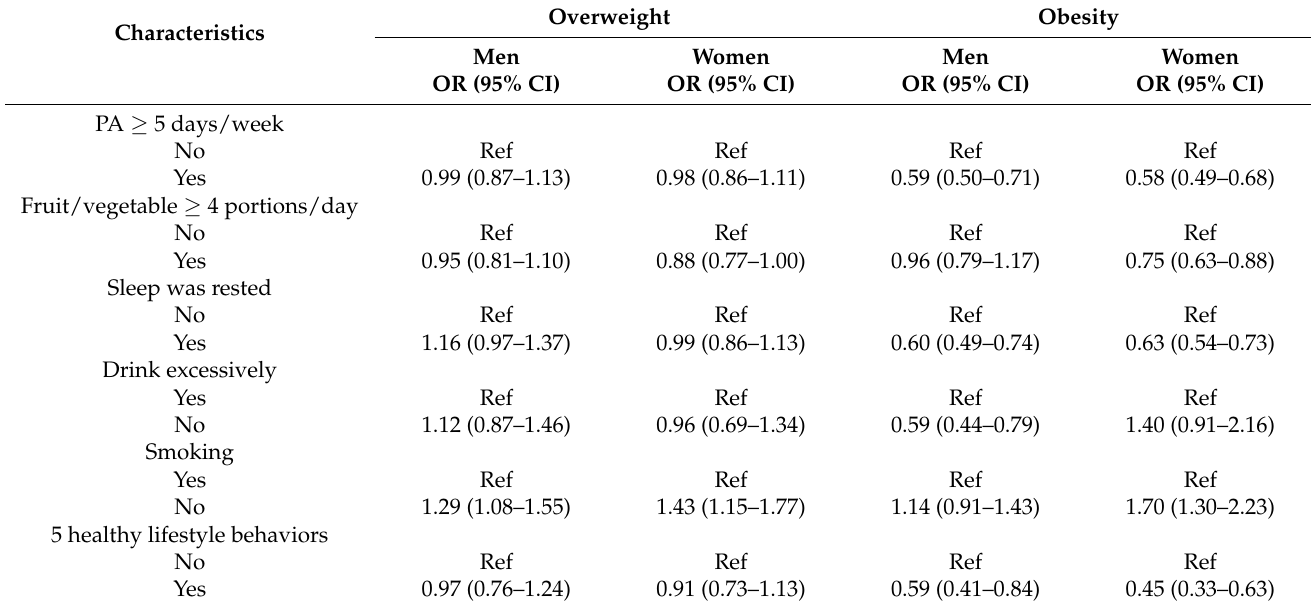
Table 4. Adjusted odds ratios for overweight and obesity among older adults for men and women.